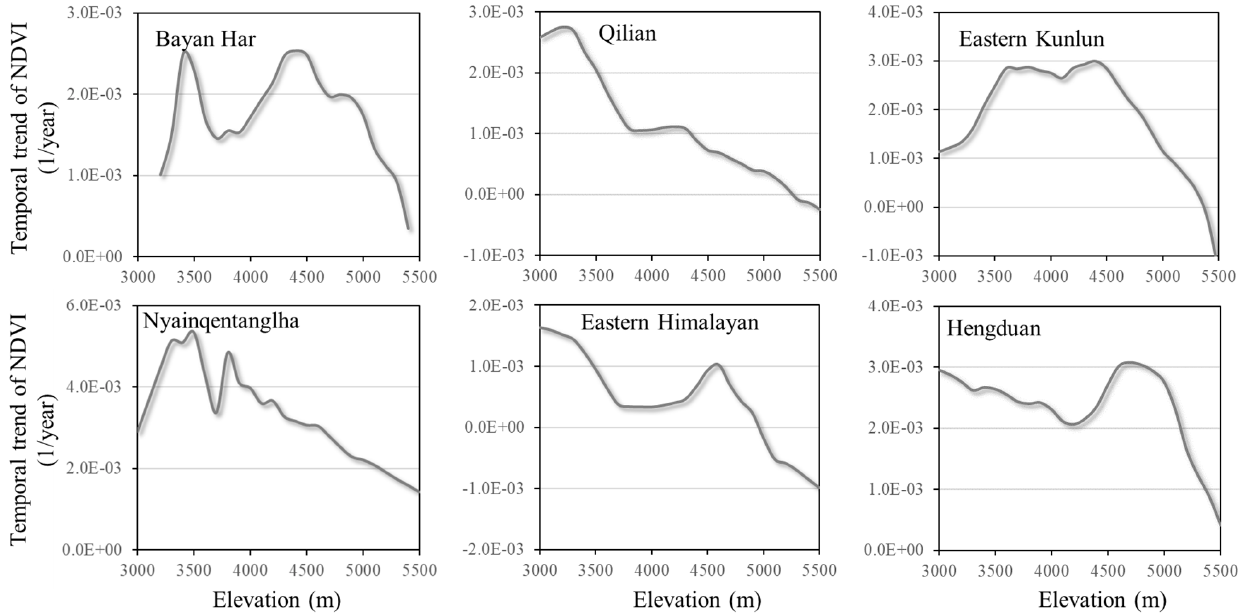
Figure 5. The temporal trend (1990–2019) of NDVI during the growing season for each elevation bin in the six mountainous regions. Noted: the values of the y -axis differ for different panels.